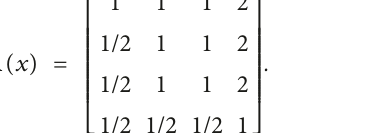
Table 2: PVs estimates derived from A ( x ) with application of the particular AP and two characteristics of PVs estimates quality in relation to the genuine PV for the case.